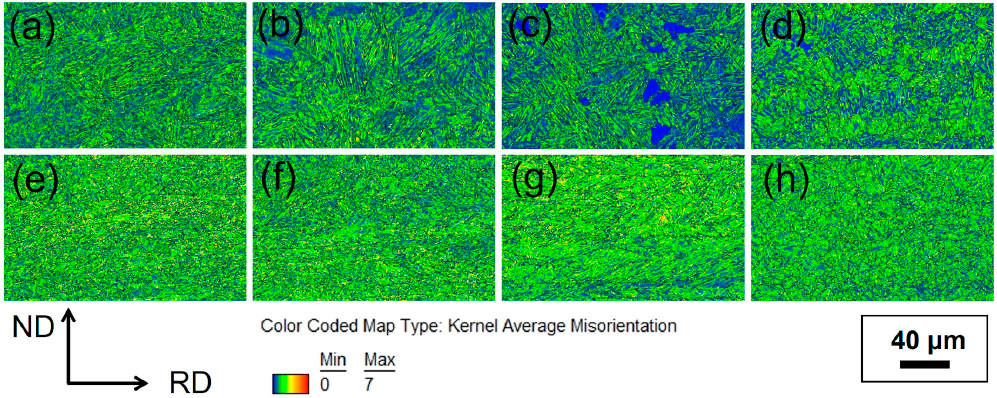
Figure 6. Kernel average misorientation (KAM) analyses of S690Q steel after tempering at ( a ) 600 °C, ( b ) 660 °C, ( c ) 720 °C, and ( d ) 780 °C for 1 h, and NiCu steel after tempering at ( e ) 600 °C, ( f ) 660 °C, ( g ) 720 °C, and ( h ) 780 °C for 1 h. RD is the rolling direction, and ND is the normal direction of the steel plate.